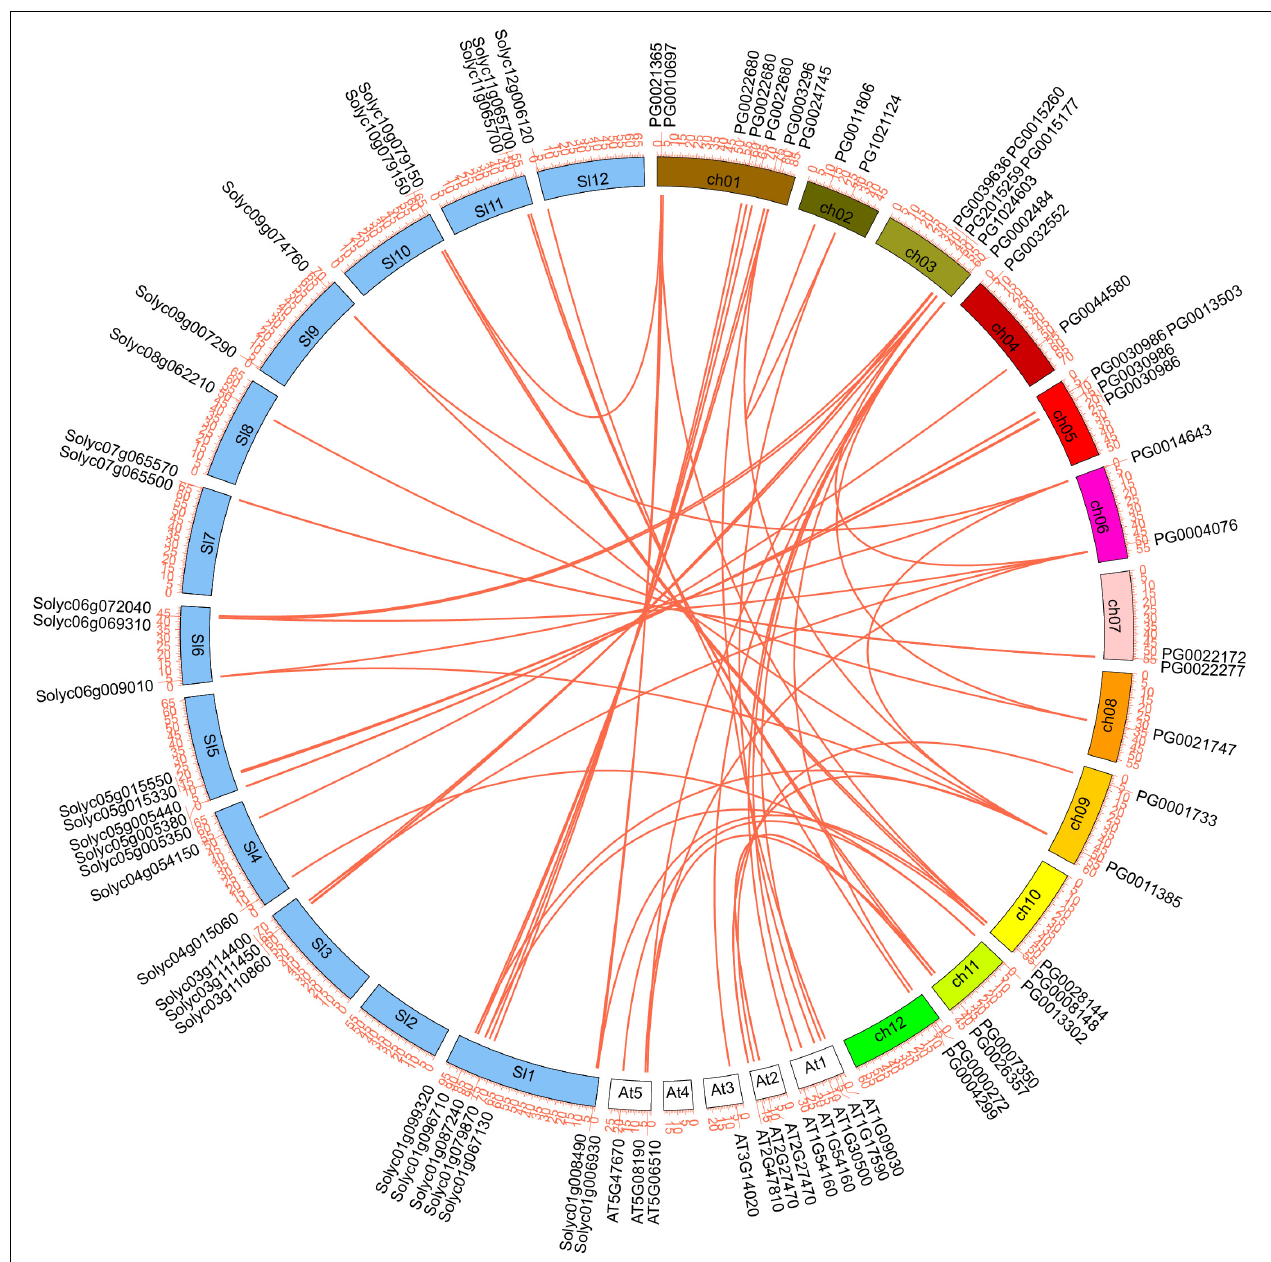
FIGURE 6 | The segmental replication events of StNF-Y genes in potato and the orthologous relationships of StNF-Y genes with tomato and Arabidopsis . Red lines indicate segmental duplication of StNF-Y genes and the orthologous relationships of StNF-Y genes with tomato and Arabidopsis . The chromosome number is indicated at the middle of each chromosome. The white boxes represent Arabidopsis chromosome, the blue boxes represent tomato chromosome, and the colored boxes represent potato chromosome,